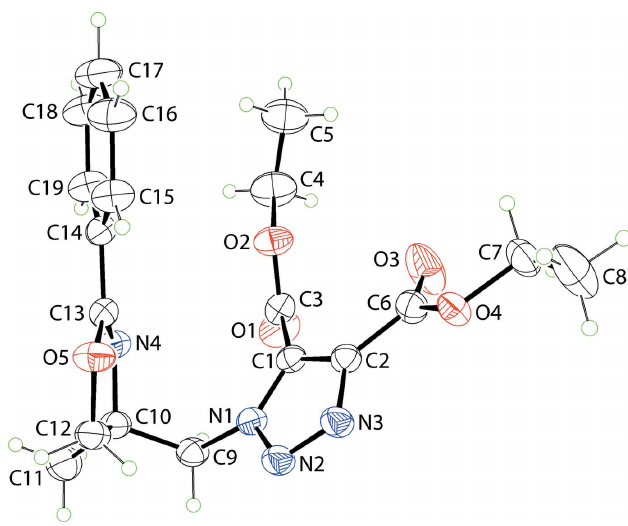
Figure 1 The structure of the title compound, showing the atom-labelling scheme. Displacement ellipsoids are drawn at the 35% probability level. H atoms are represented as small spheres of arbitrary